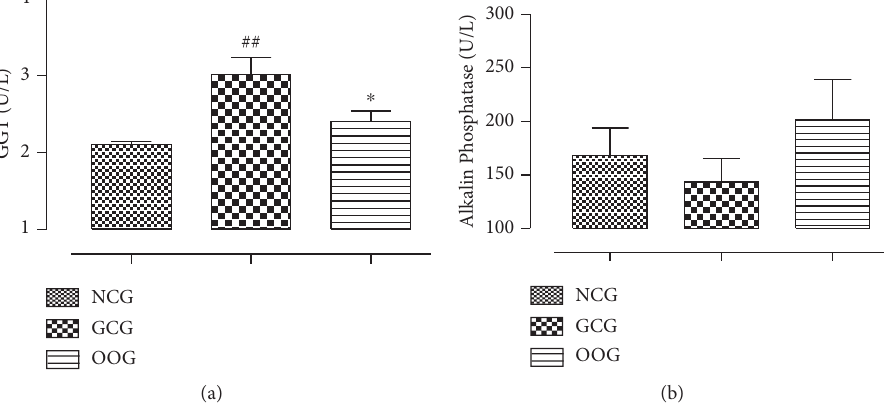
Figure 2: The amount of plasma GGT (a) and ALP (b) for all treated group animals. ## P < 0 . 01, compared to the NCG. ∗ P < 0 . 05, compared to the